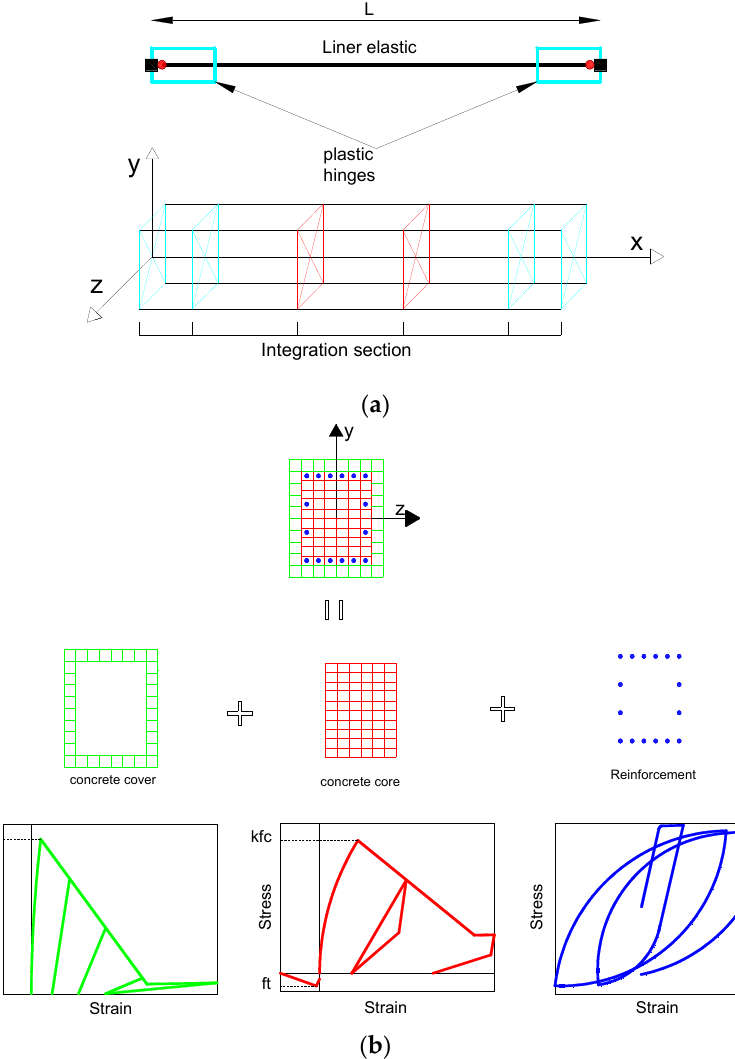
Figure 3. Adopted strategy for modelling RC elements. ( a ) Beam with hinge element general description. ( b ) Fiber section discretization. i. unconfined concrete (Concrete01) ii. confined concrete (concrete02) iii. Steel material